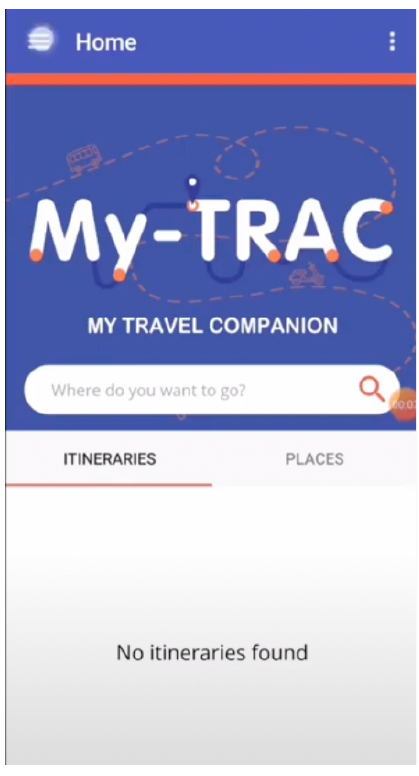
Figure 3. My-Trac application.